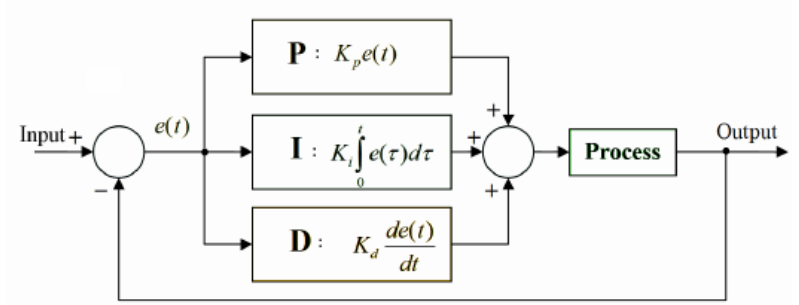
Figure 1. PID Controller Model